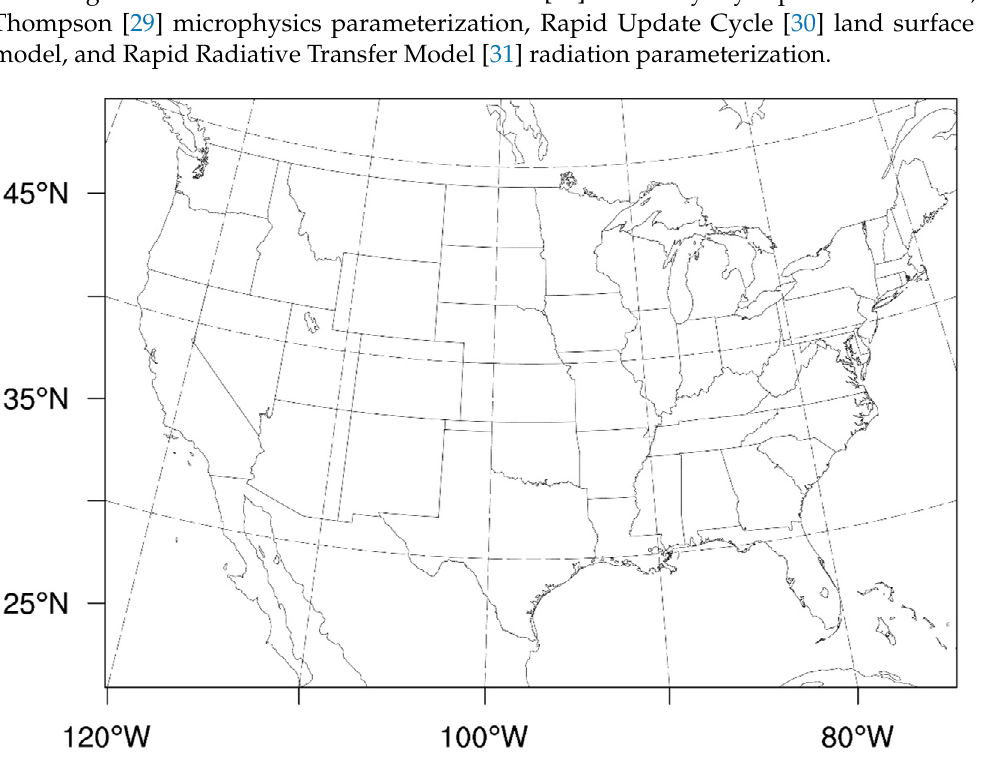
Figure 1. Flowchart for the EDA system at a particular DA cycle, t. The green box indicates the 147 assimilation of conventional observations, and the red box includes the assimilation of radar- 148 reflectivity observations. See text for details. 149